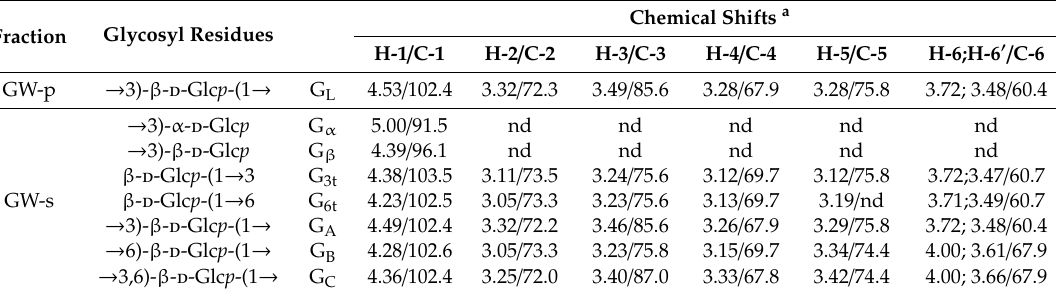
Table 4. 1 H and 13 C NMR chemical shifts of GW-p and